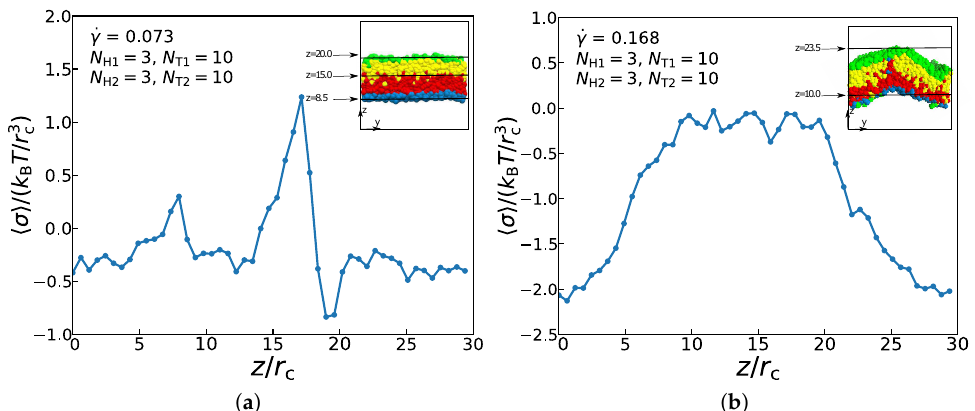
Figure 9. The interface tension (cid:104) σ (cid:105) as functions of distance along z -direction for the asymmetric membrane in the case of ( a ) ˙ γ = 0.073 and ( b ) ˙ γ = 0.168. The snapshots of asymmetric membranes are also